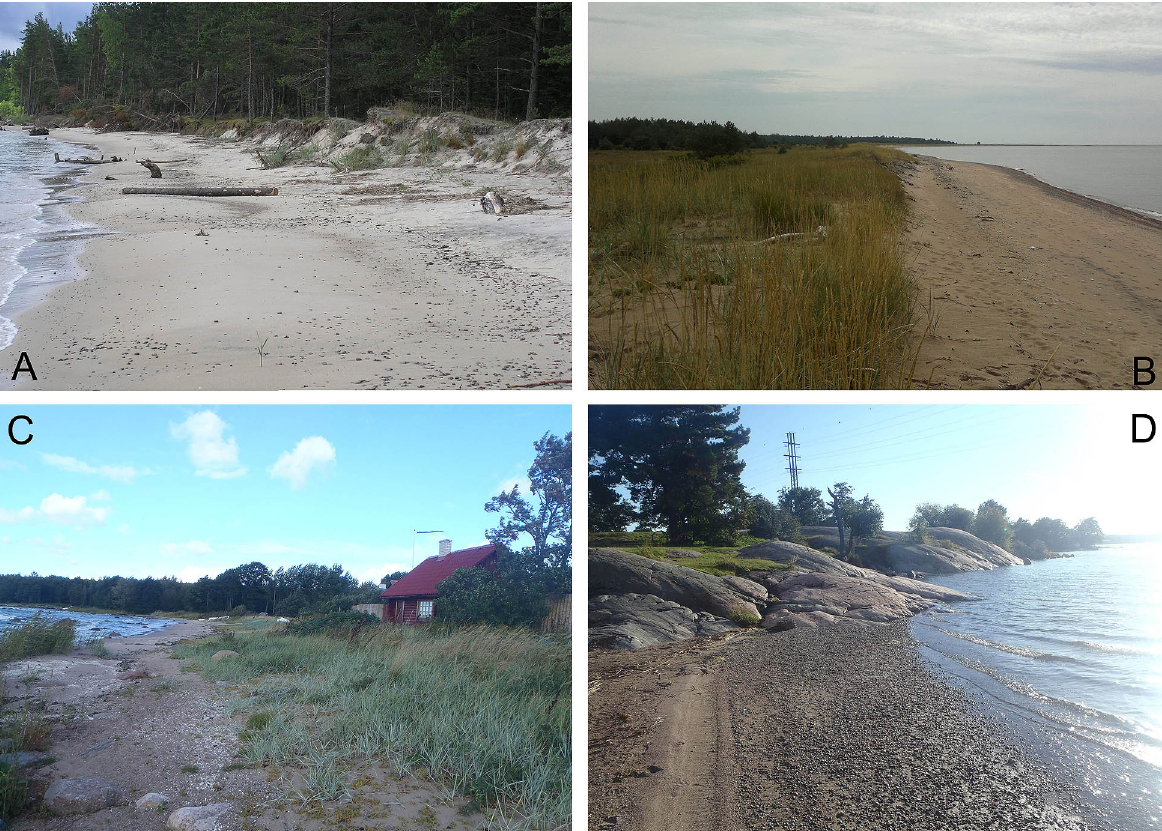
Fig. 9. Low and scarce sandy coast in North-east part of Baltic